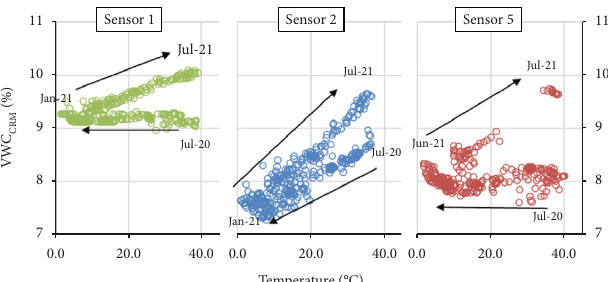
Figure 16: Moisture vs. temperature relations for sensors 1, 2, and 5 (peaks